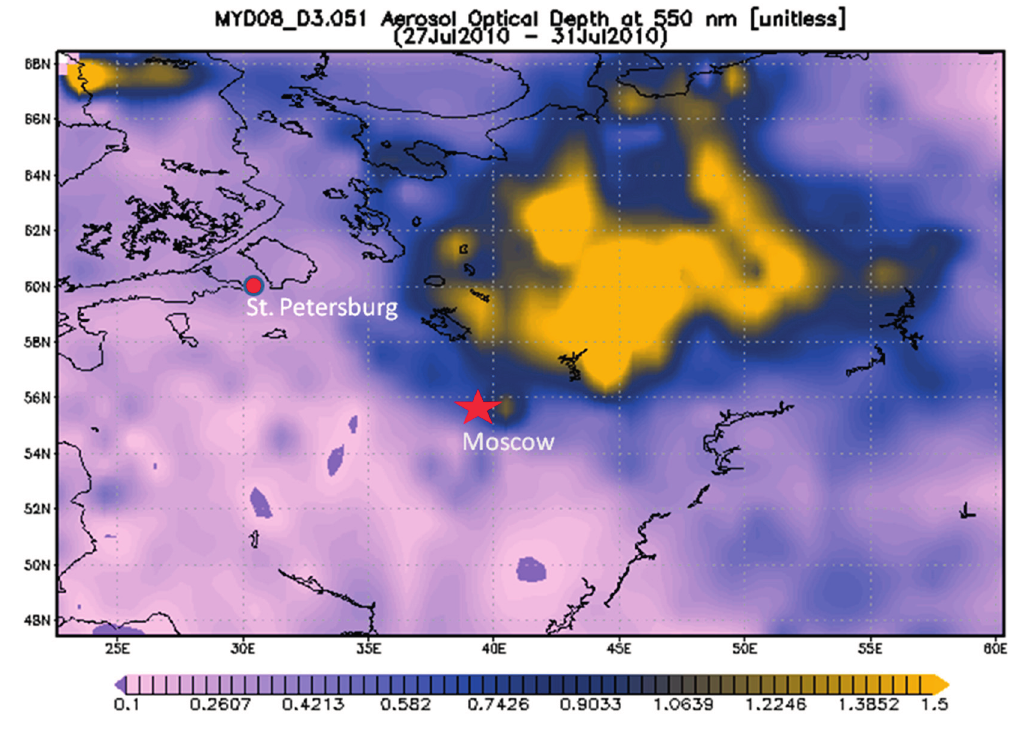
Figure 1. MODIS Aerosol Optical Depth (AOD) image showing the large area of elevated aerosol concentrations northeast of Moscow (yellow), stemming from massive wildfires that erupted in the hot summer of 2010. The daily AOD data was acquired for the period 27–31 July 2010, and averaged over this time period with